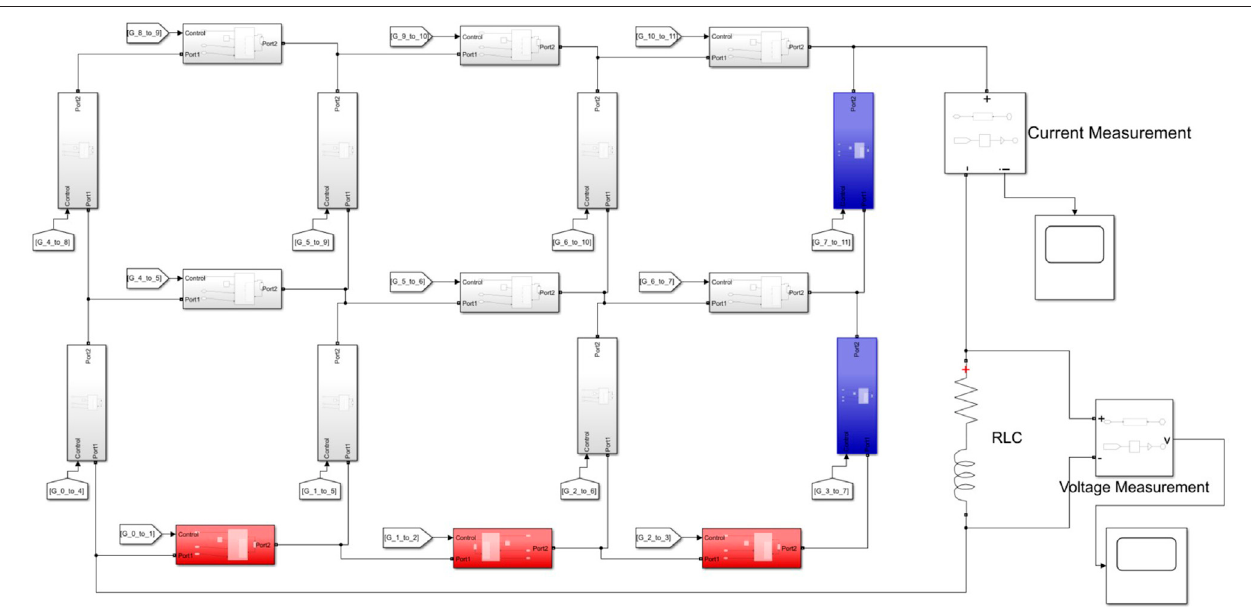
FIGURE 14 | Simulated 3 × 4 lattice power grid with measurement